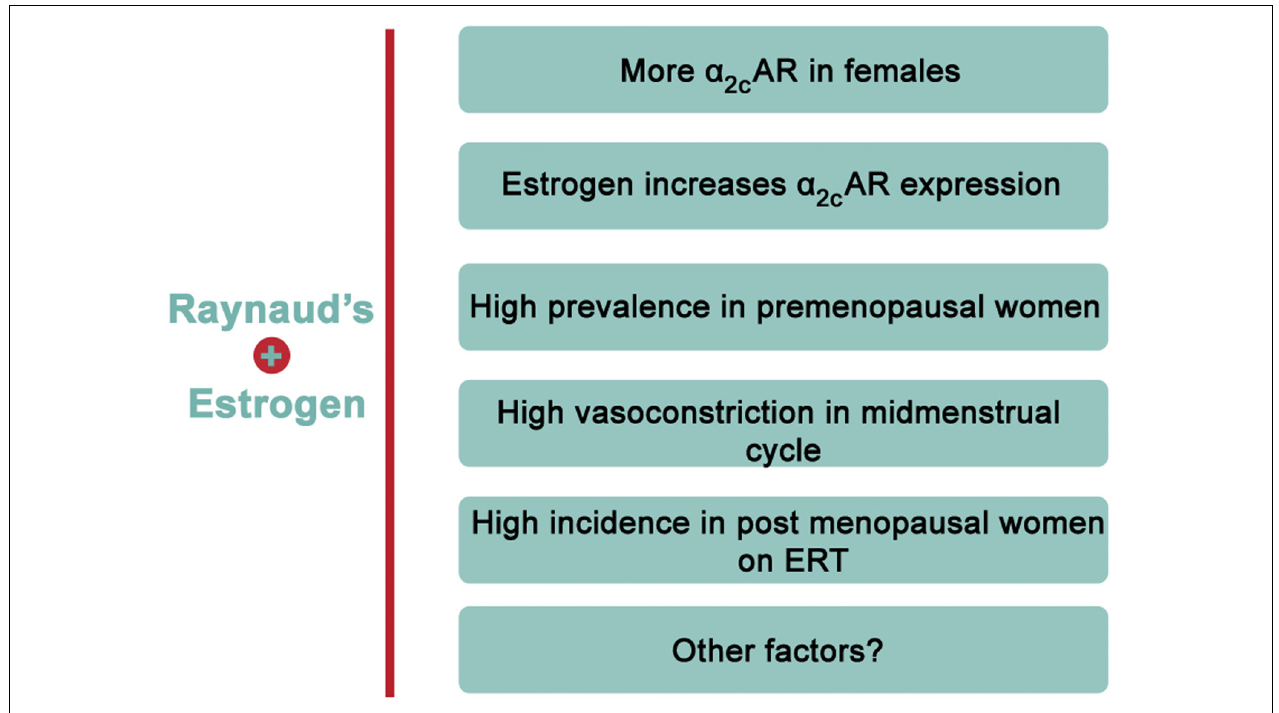
FIGURE 2 | Evidence of positive association between estrogen and RP. Accumulating evidence points to an overwhelming association between estrogen and RP. For instance, estrogen increases α 2C -AR but not α 2 A -AR in human arteriolar smooth muscle cells. Moreover, females have higher expression of α 2C -AR than males. Epidemiologically, RP is reported to have remarkably high incidence in premenopausal females or post-menopausal females on estrogen replacement therapy